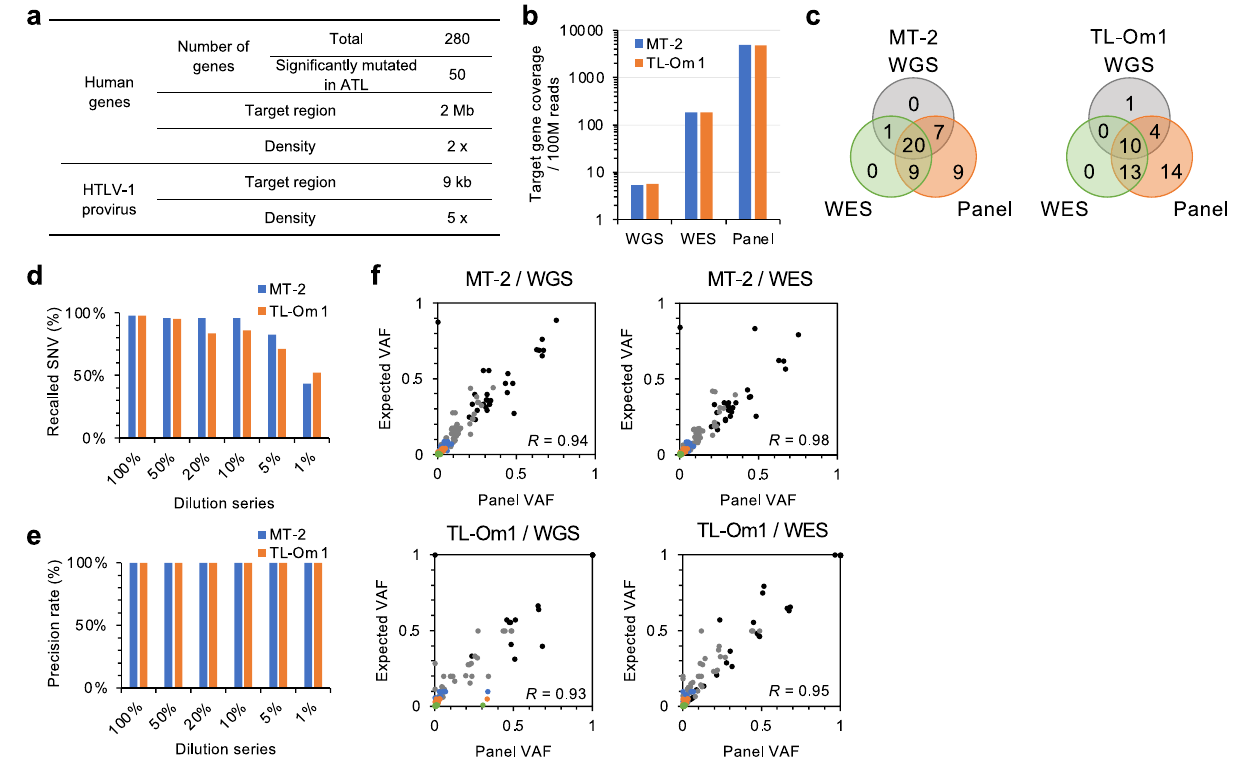
Fig. 1 Performance evaluation of HTLV-1/ATL panel for human genome sequencing. a Summary of the HTLV-1/ATL panel. b Bar graph shows target gene coverage per 100 million reads in different sequencing platforms. c Venn diagrams depict overlap between detected SNVs by WGS, WES, and panel- based Target-seq in MT-2 (left) and TL-Om1 (right). d , e Bar graphs show proportion of recalled SNVs ( d ) and precision rates ( e ) by panel-based deep sequencing from serial diluted samples. SNVs detected by WGS were used as reference. f Scatter plots show observed VAF ( x -axis) and expected VAF ( y - axis) of detected SNVs in MT-2 (upper) and TL-Om1 (lower). The expected values were calculated from WGS and WES dataset diluted to 100% (black), 50% (dark gray), 20% (gray), 10% (blue), 5% (orange), and 1% (green). Correlation coef fi cients ( R ) are provided in the